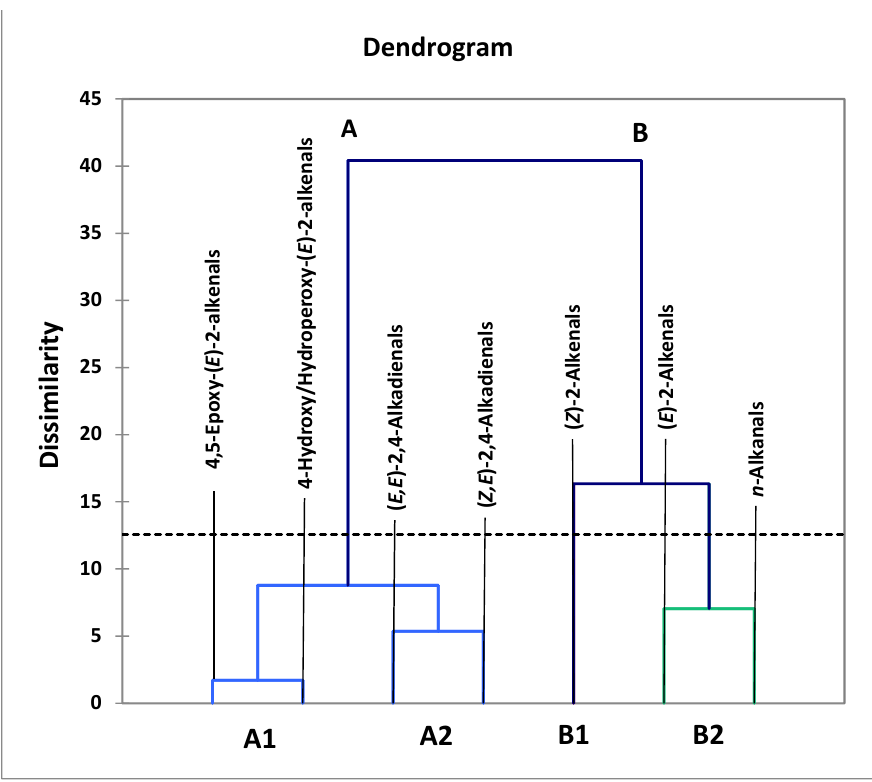
Figure 4. AHC clustering analysis of a model dataset containing 7 aldehyde classification variables, the concentrations of which were those generated at all 7 LSSFE heating time-points. Two major clusters were isolated, the first containing structurally complex aldehydes arising from PUFA per- oxidation (cluster A), the second structurally simpler ones generated from both MUFA and PUFA peroxidation (cluster B). Clusters A and B were both split into two sub-clusters, A1 and A2, and B1 and B2, respectively. However, from the dissimilarity truncation value (dotted horizontal line), only the B1/B2 sub-clustering split was found to be statistically